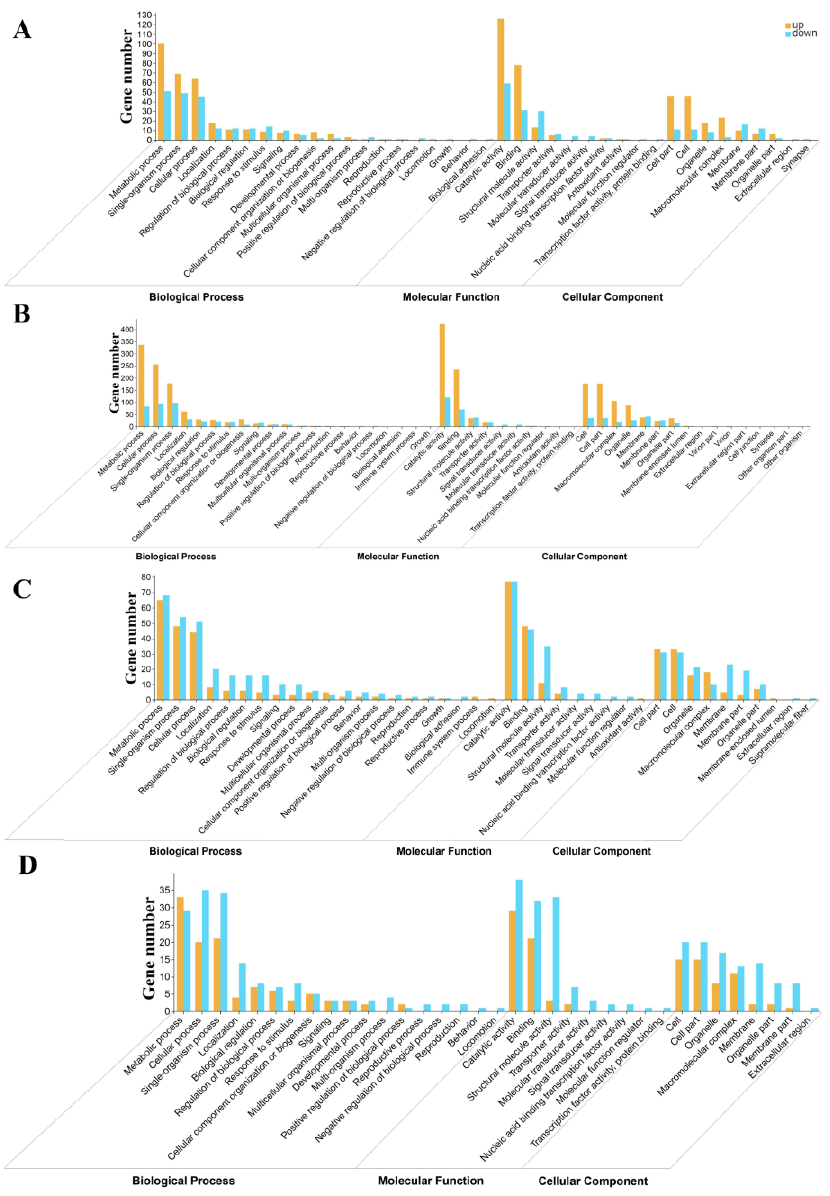
Figure 4. GO enrichment analysis of differentially expressed genes CK (control) vs. 1d ( A ), CK vs. 3d ( B ), CK vs. 5d ( C ), and CK vs. 7d ( D ).